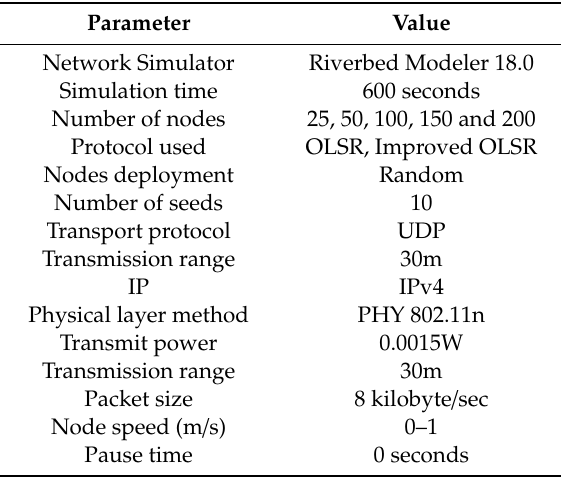
Table 5. Simulation